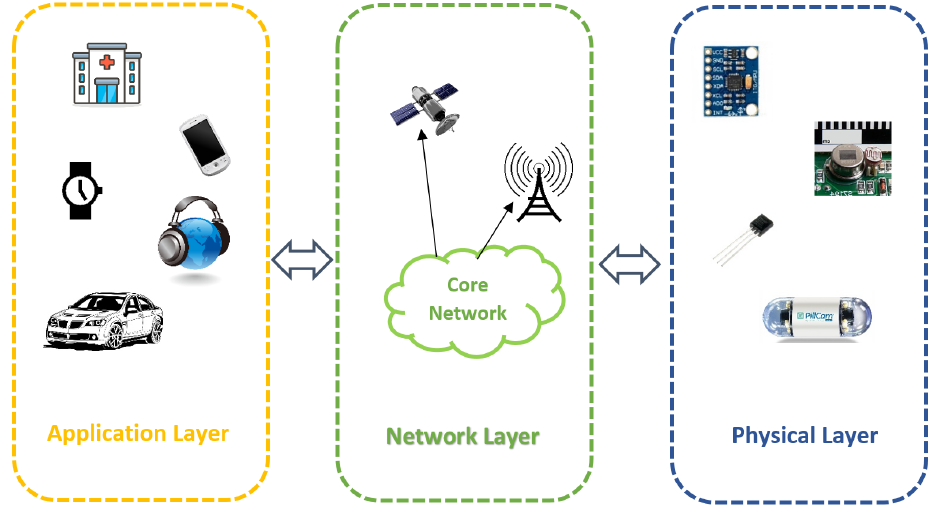
Figure 1. IoT architecture.